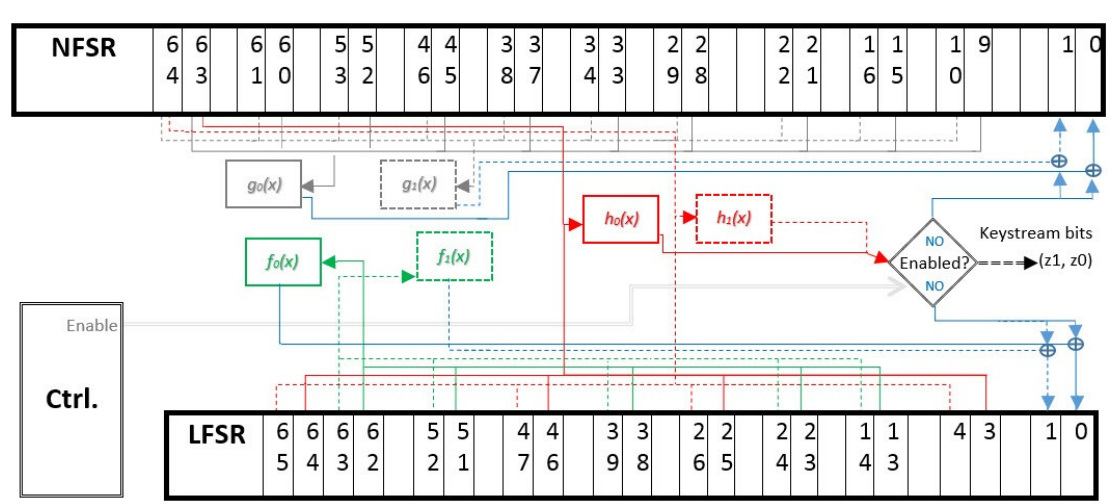
Figure 3. Grain-80 architecture with no unrolling.